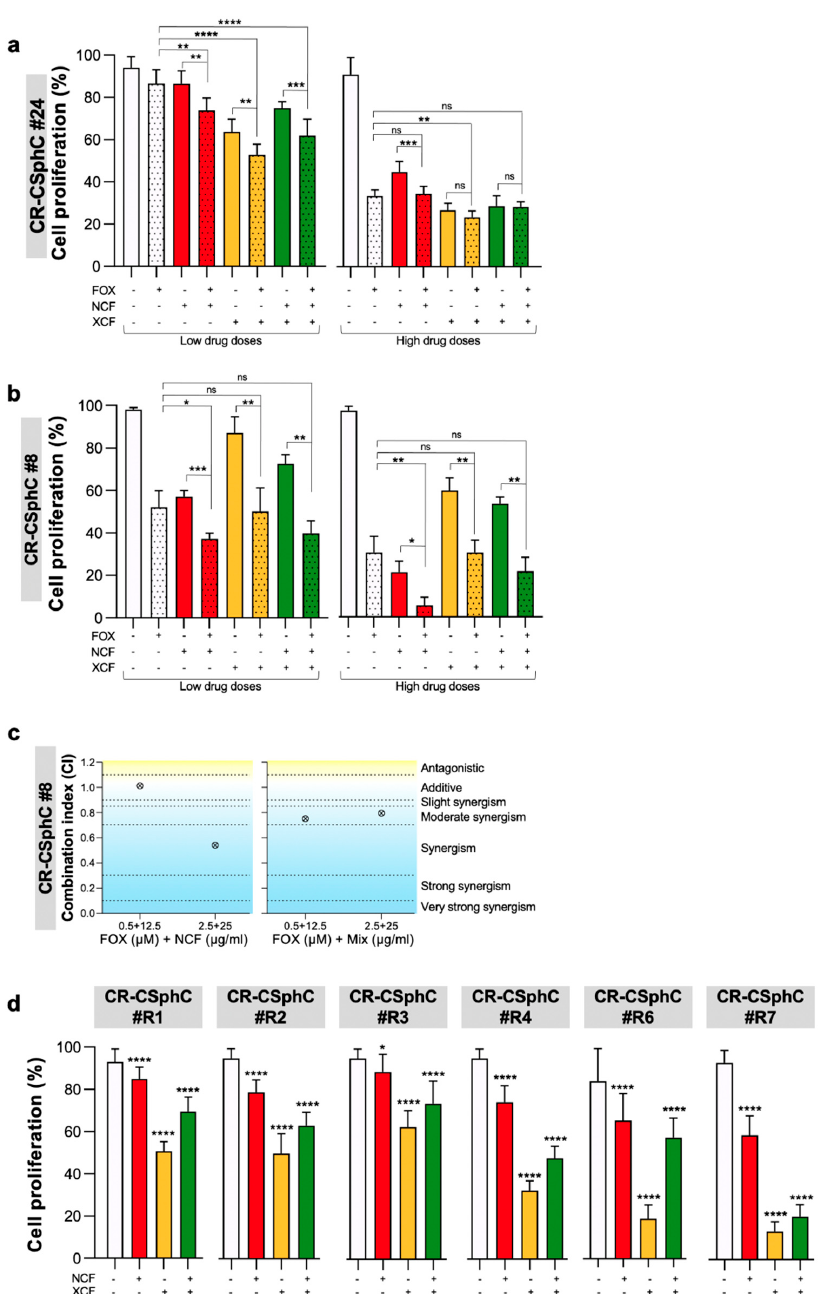
Figure 2. Combination of NCF plus chemotherapy hampers the proliferation of CR-CSphCs. ( a ) Cell proliferation percentage of CR-CSphCs (#24) treated with 25 or 40 µg/mL of NCF, XCF, or Mix extracts alone or in combination with 1.25 or 5 µM FOX for 48 h. Data are represented as mean ± SD of three independent experiments. Comparisons between two groups were made using a two-tailed Student’s t -test: ns, not significant, ** p ≤ 0.01, *** p ≤ 0.001, **** p ≤ 0.0001; ( b ) cell proliferation percentage of CR-CSphCs (#8) treated with 12.5 or 25 µg/mL of NCF, XCF, or Mix extracts alone or in combination with 0.5 or 2.5 µM FOX for 48 h. Data are represented as mean ± SD of three independent experiments. Comparisons between two groups were made using a two-tailed Student’s t -test: ns, not significant, * p ≤ 0.05, ** p ≤ 0.01, *** p ≤ 0.001; ( c ) synergy plot representing the combination index (CI), computed in CompuSyn by using the Chou–Talalay method, calculated from cell proliferation data of CR-CSphCs (#8) treated with different FOX and NCF and Mix dose pair at 48 h; ( d ) cell viability of metastatic CR-CSCs exposed for 72 h to 40 µg/mL NCF, XCF, or both extracts (Mix), as compared to control (vehicle). * p ≤ 0.05, **** p ≤ 0.0001.